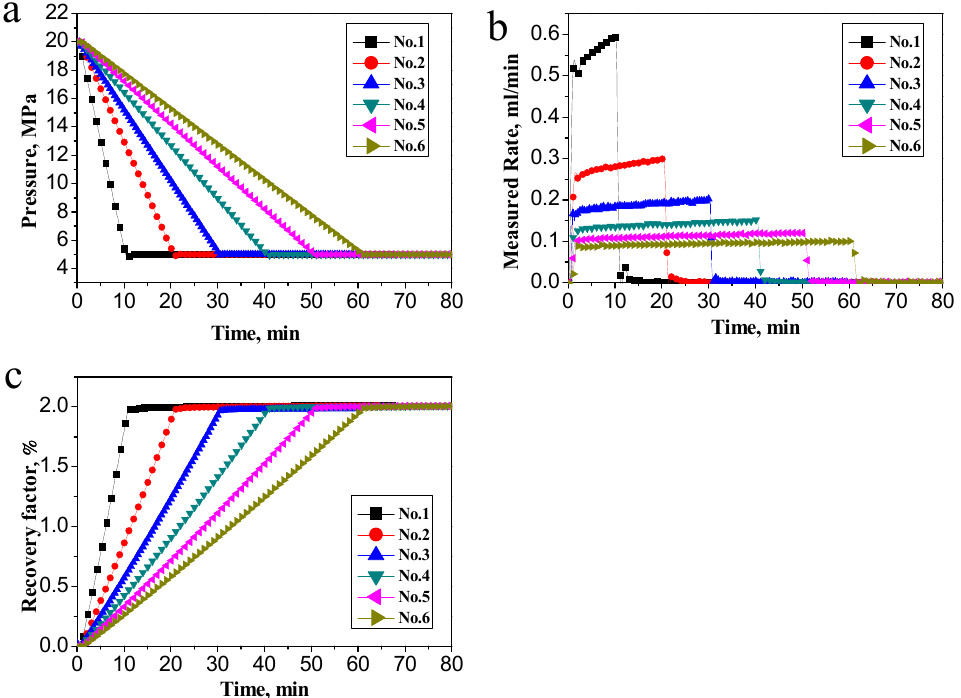
Figure 4. Pressure, oil production rate and recovery factor of six different kinds of linear pressure depletion. ( a ) Pressure depletion with different depletion rate; ( b ) Oil production rate with different depletion rate; ( c ) Oil recovery factor with different depletion rate.